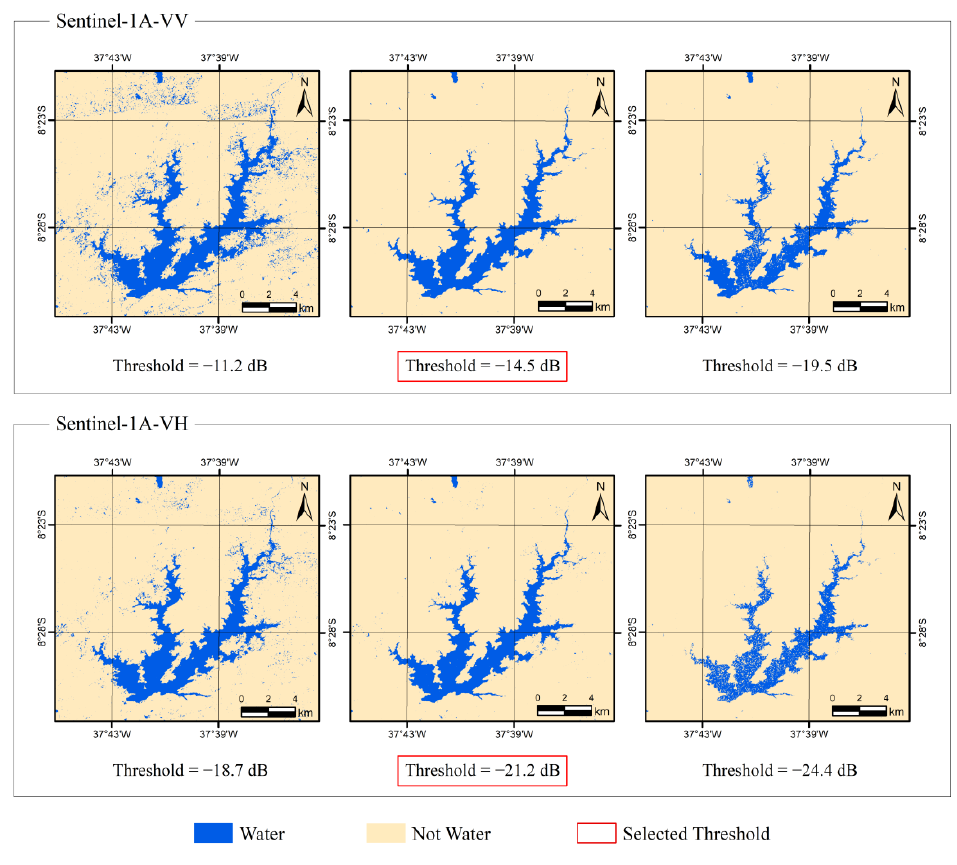
Figure 7. Water segmentation threshold variation for the date 5 June 2020.